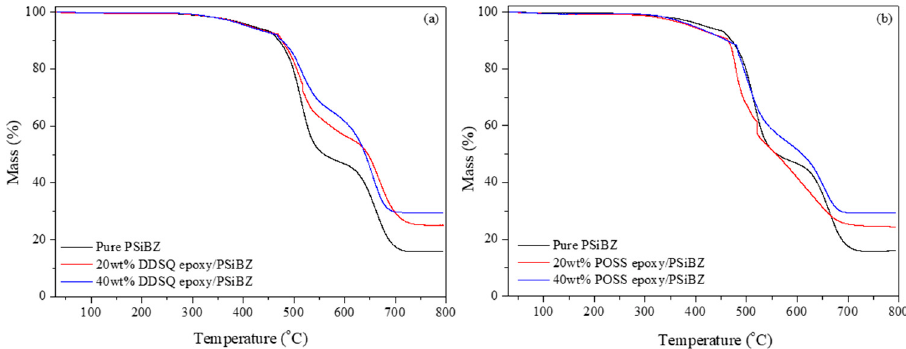
Figure 3. TGA thermograms of ( a ) DDSQ/PSiBZ nanocomposites and ( b ) POSS epoxy/PSiBZ nanocomposites.